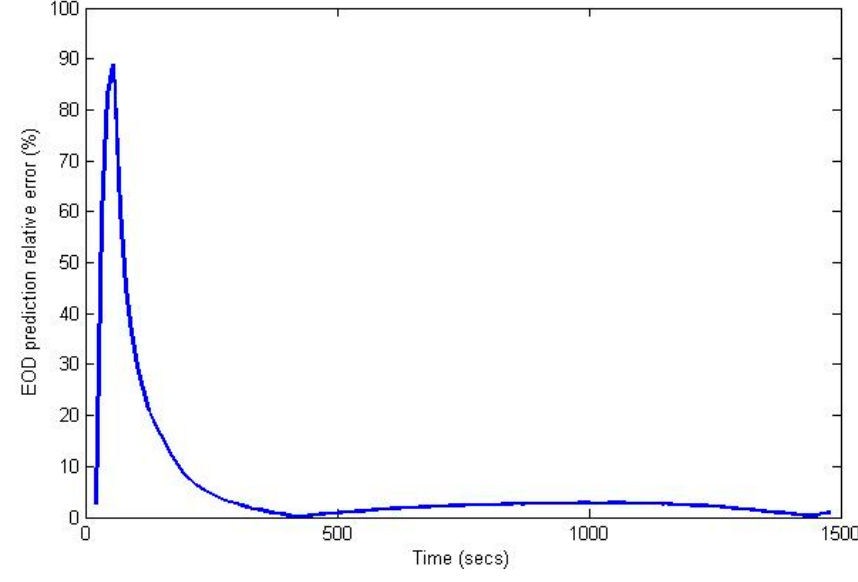
Figure 16. EOD prediction error in last discharge cycle of cell B0038.